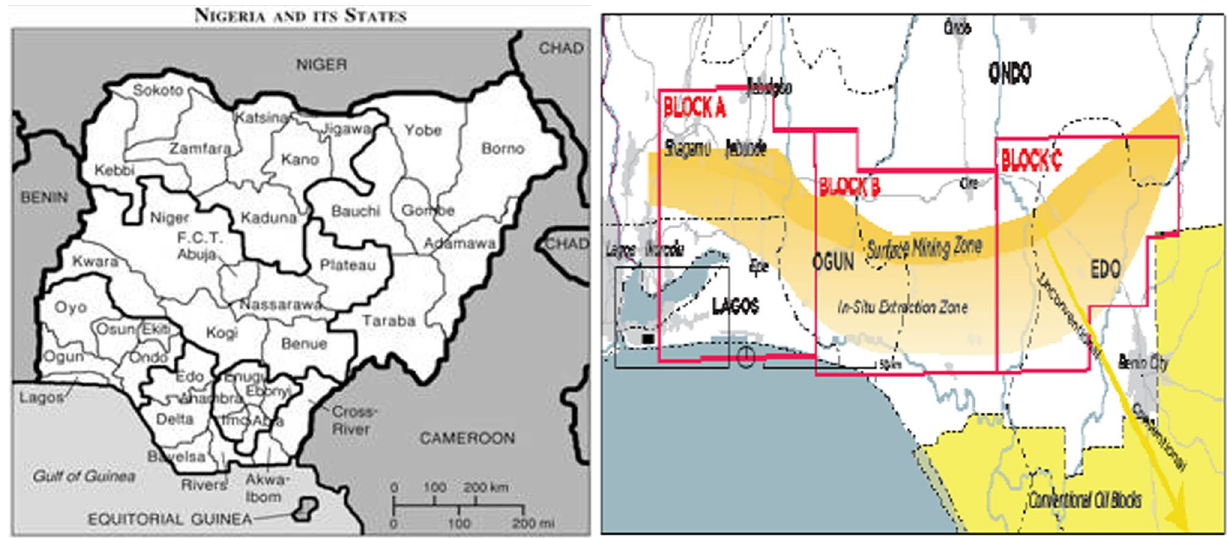
Fig. 1 Map of Nigeria showing the states (left, Source: Geography Blog) and the bitumen belt [right, Source: Milos (2015)]